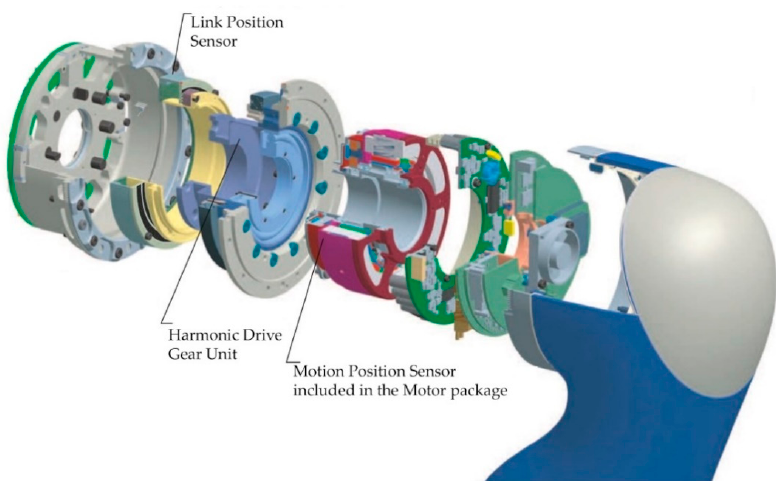
Figure 3. The joint module of the Light WeigthRobot III, adapted from Institute of Robotics and Mechatronics of German Aerospace Center (Deutsches Zentrum für Luft-und Raumfahrt-DLR)